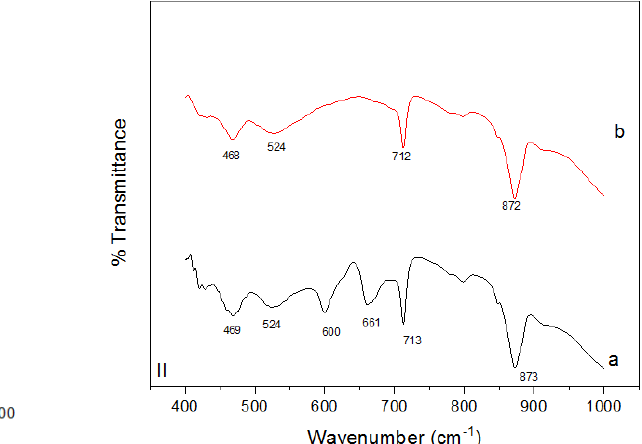
Table 1. Physicochemical Property of Odaracha Soil.